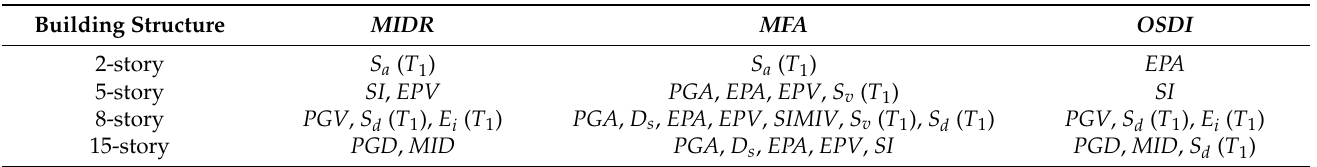
Table 7. The most sufficient IMs for different structures.